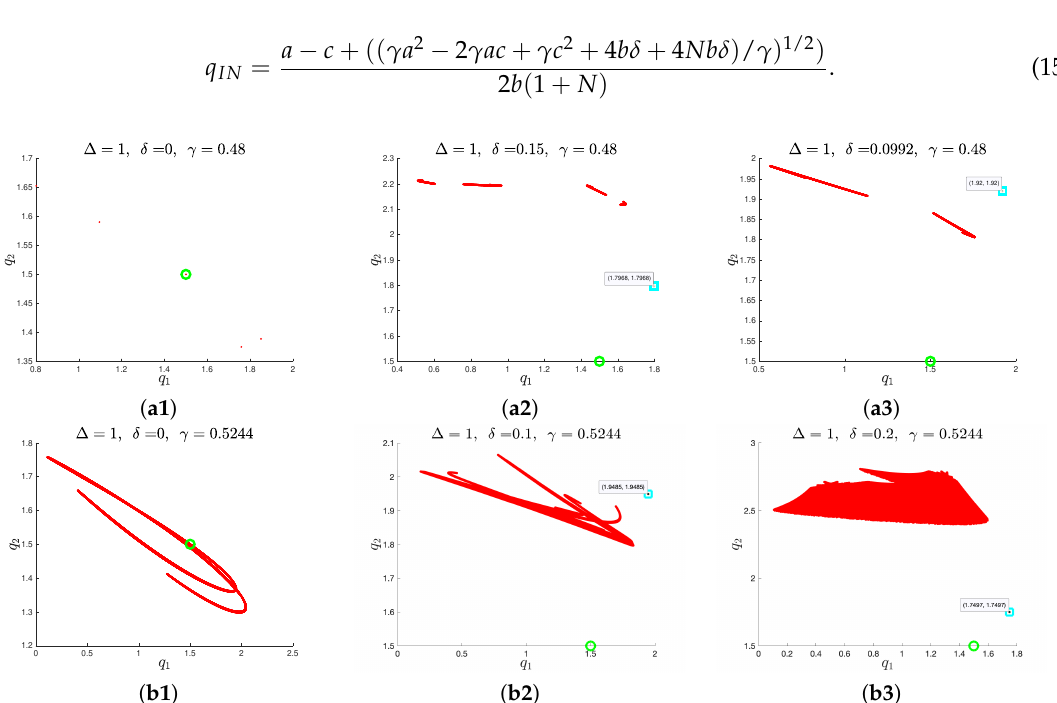
Figure 6. Density plots of IHCOM Equation (11): (( a1 )–( a3 )) for γ = 0.48 and (( b1 )–( b3 )) for γ = 0.5244; here, the green circle stands for ( q N , q N ) equilibrium of HCOM, and the cyan box for ( q IN , q IN ) equilibrium of IHCOM.